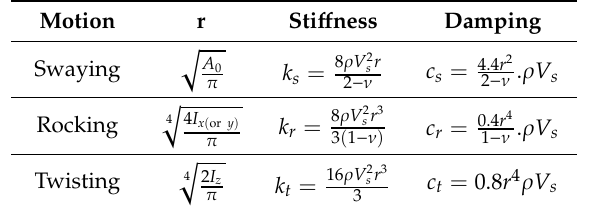
Table 1. Dynamic properties of the springs and dashpots in the swaying, rocking and twisting directions for simulating soil–structure interaction (SSI) e ff ects [32].